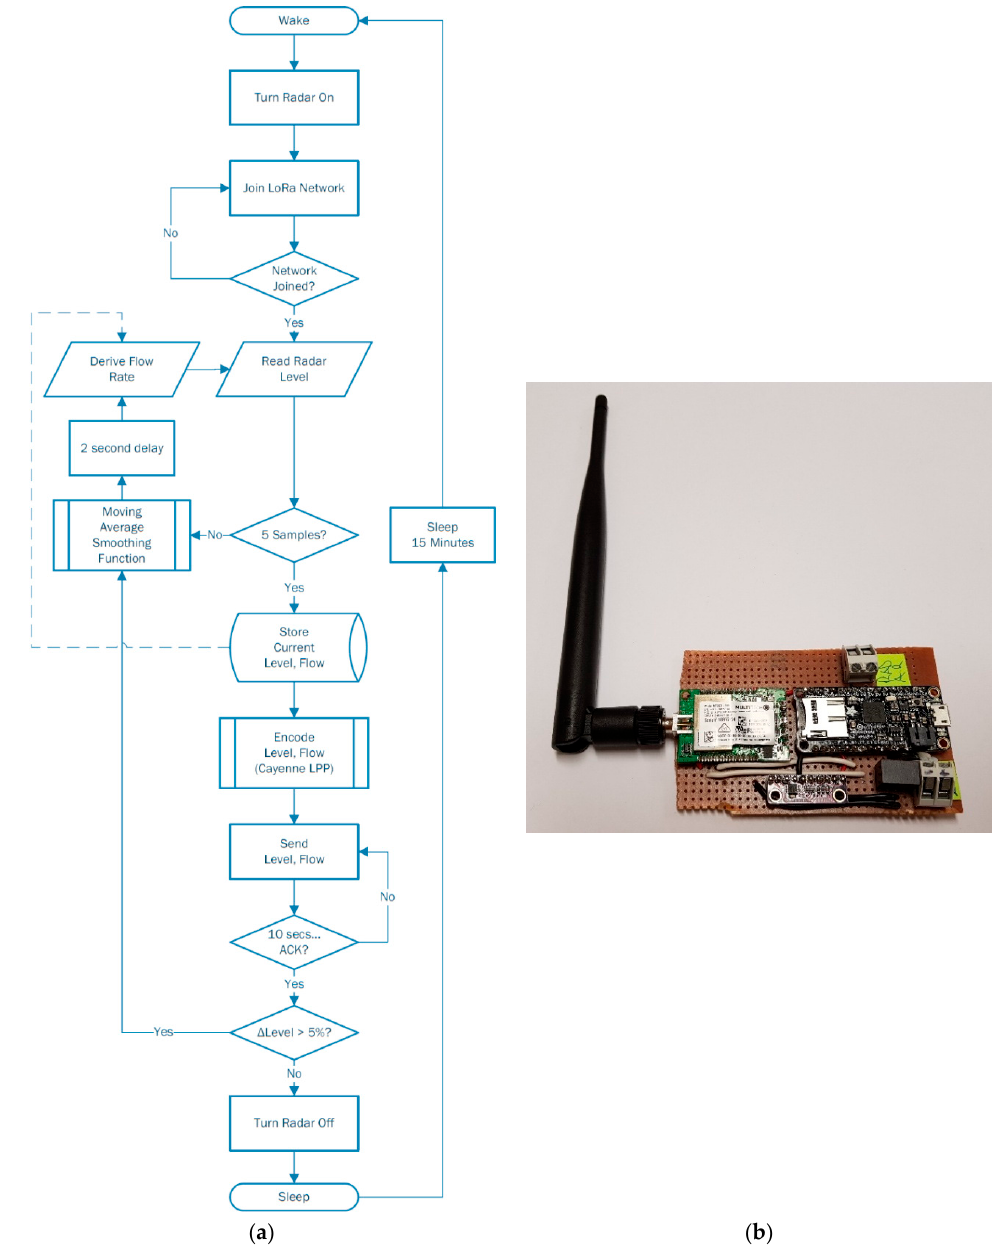
Figure 19. Prototype LoRa radar sensor device ( a ) Flow of operation, and ( b ) Interface board. Table 2. Radio channel ranging survey statistics.